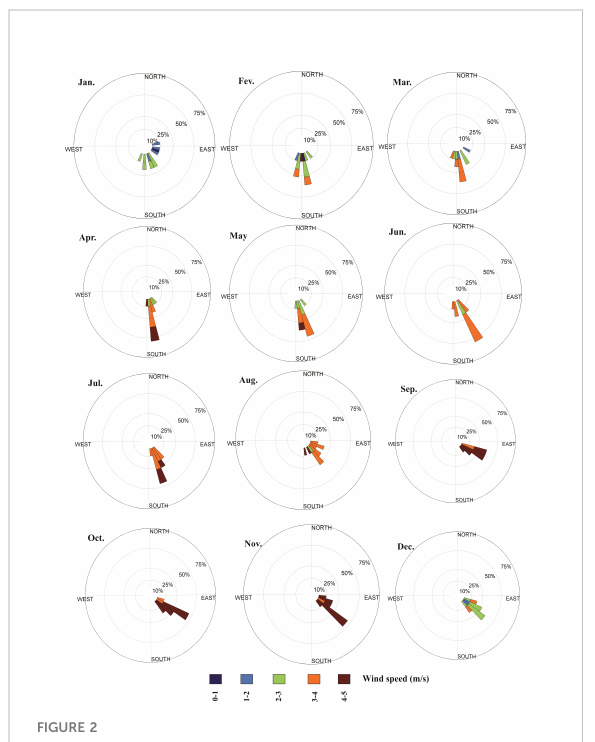
FIGURE 2 Monthly climatology of winds computed from NCEP/NCAR reanalysis monthly zonal and meridional components of wind over the Sofala Bank during 2003 – 2013. Source: Machaieie